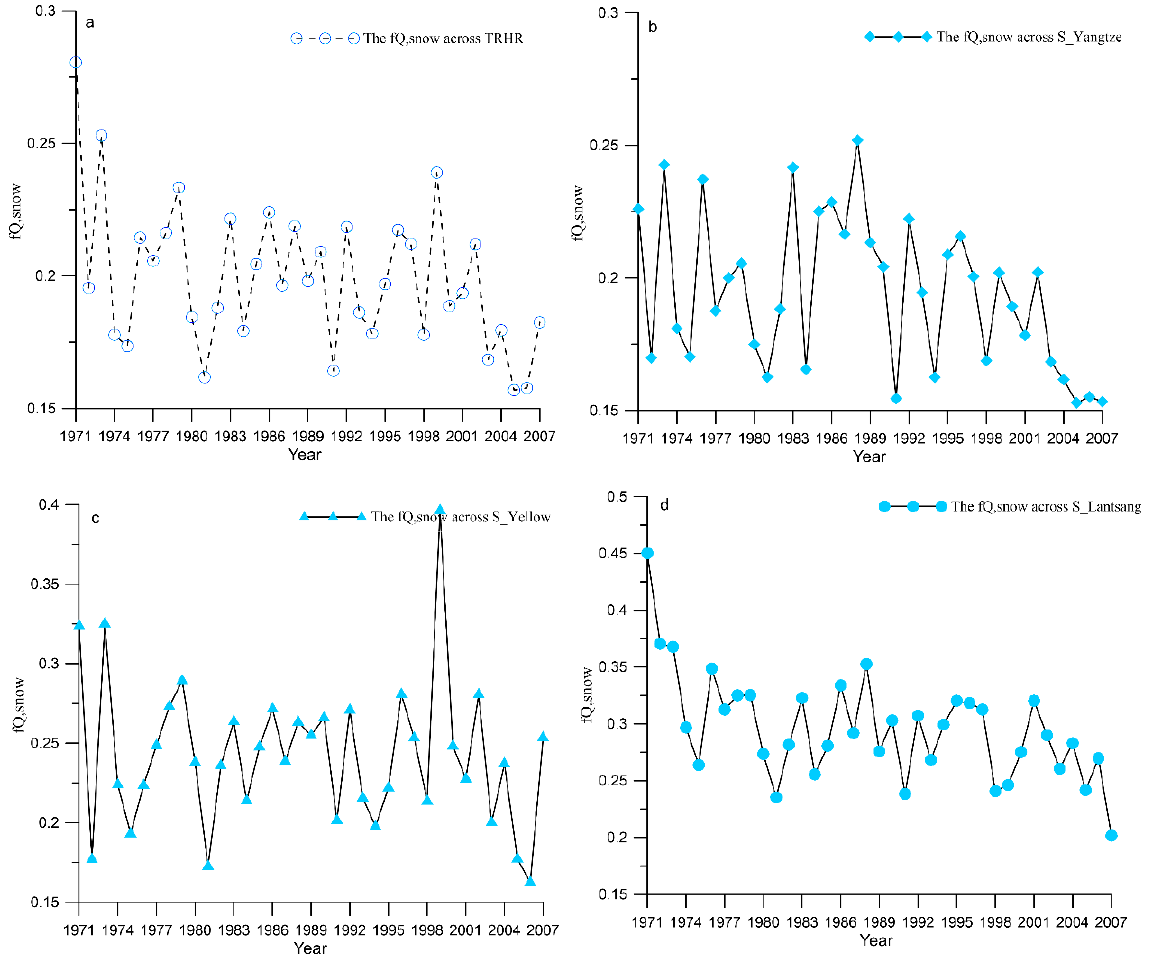
Figure 8. Annual variation of the f Q,snow from 1971 to 2007: ( a ) over TRHR ( b ) S_Yangtze; ( c ) S_Yellow; ( d ) S_Lantsang. For each sub-basin, the variation characteristic of f Q,snow depended on different in- ducements. A significant decreasing rate of f Q,snow over the S_Lantsang was the highest